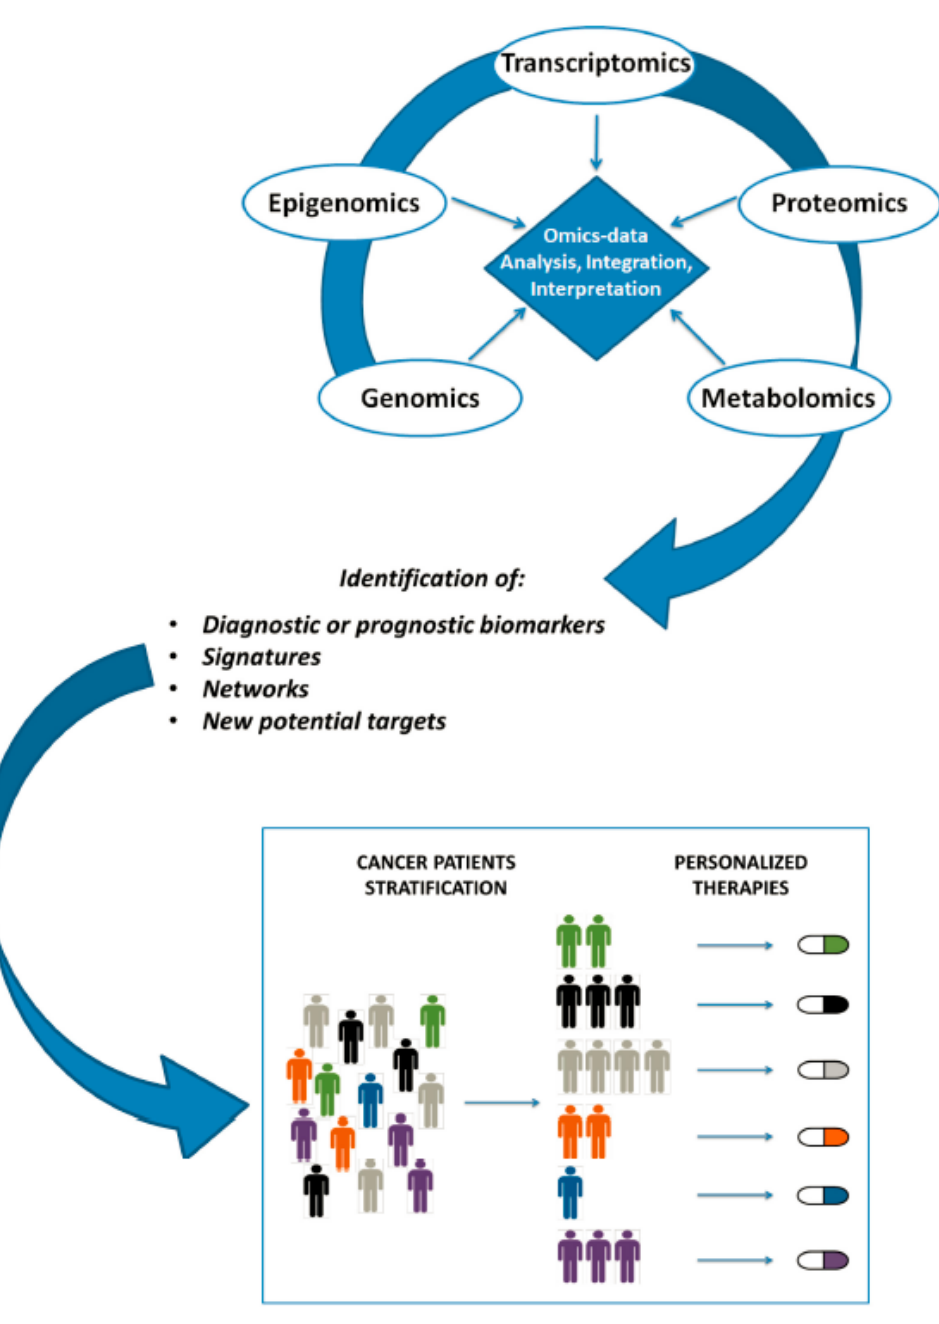
Figure A1. Schematic workflow summarizing major steps occurring from omics data production to personalized clinical decision-making. (adapted from [22]).